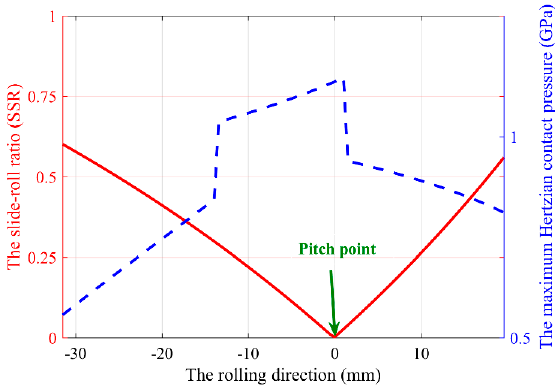
Figure 13. The maximum Hertzian contact pressure and the SRR along the LOA [104].